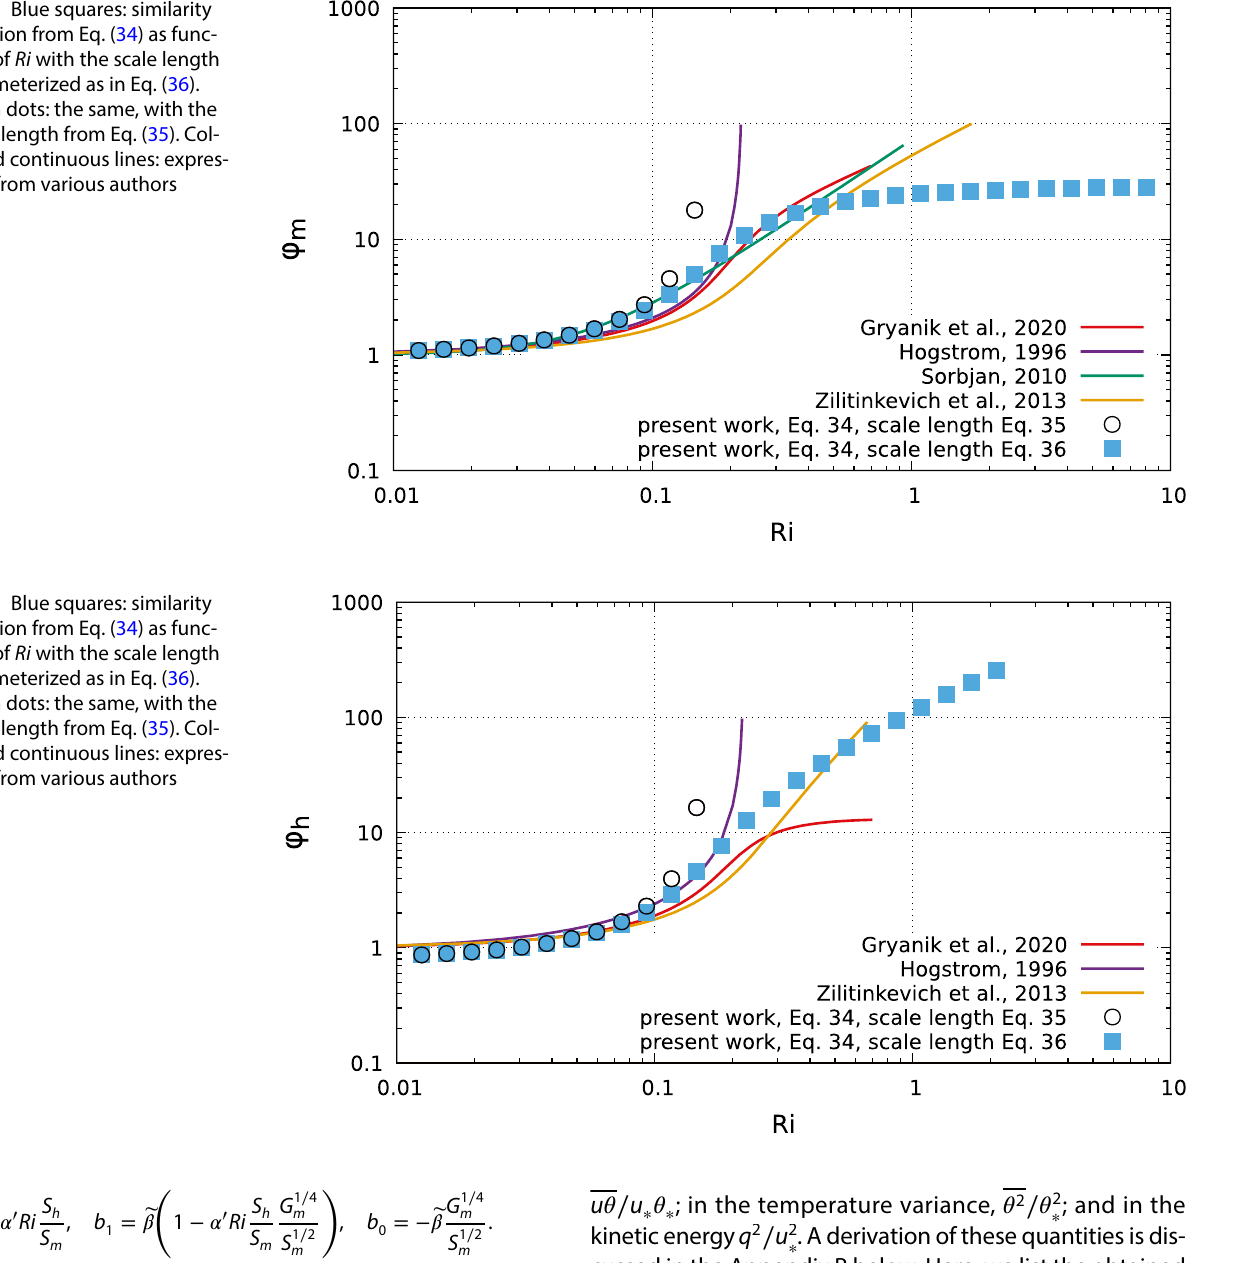
Fig. 1 Blue squares: similarity function from Eq. (34) as func- tion of Ri with the scale length parameterized as in Eq. (36). Open dots: the same, with the scale length from Eq. (35). Col- oured continuous lines: expres- sion from various authors